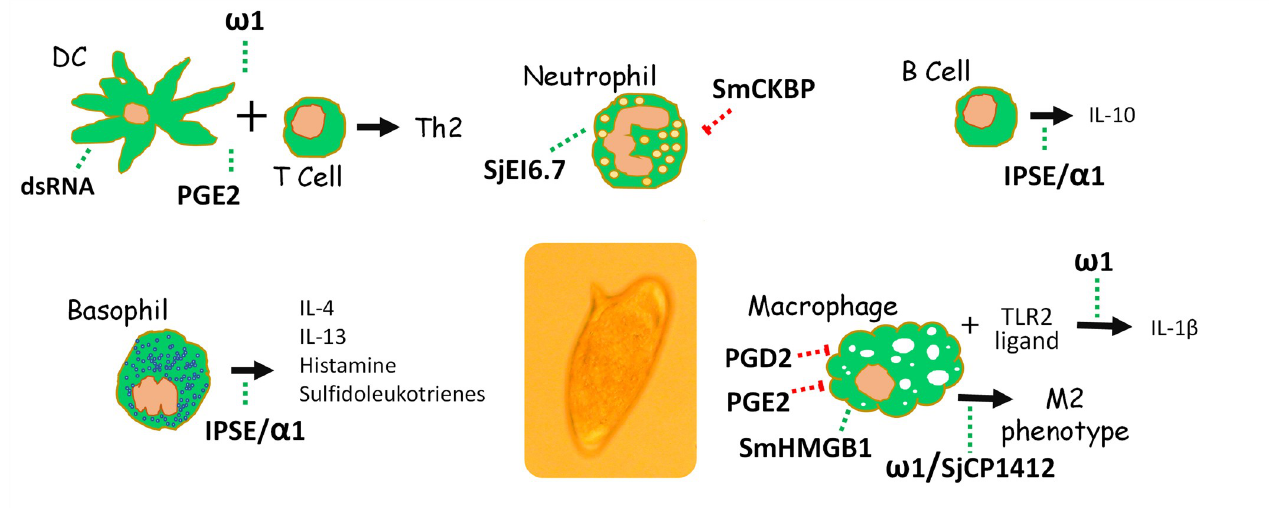
Fig 3. The impact of molecules (bold text) produced by schistosome eggs on the host immune cells indicated. The green dashed lines indicate stimulatory effects, while red dashed lines indicate inhibitory effects. An image of an S . mansoni egg is seen at center. See text for details regarding the impact of individual schistosome molecules on specific cell types. DC, dendritic cell; dsRNA, double-strand RNA; IPSE/ α 1, IL-4–inducing principle of schistosome eggs/alpha 1; PGE2, prostaglandin E2; PGD2, prostaglandin D2; SmCKBP, S . mansoni chemokine binding protein; SmHMGB1, S . mansoni high mobility group box 1 protein